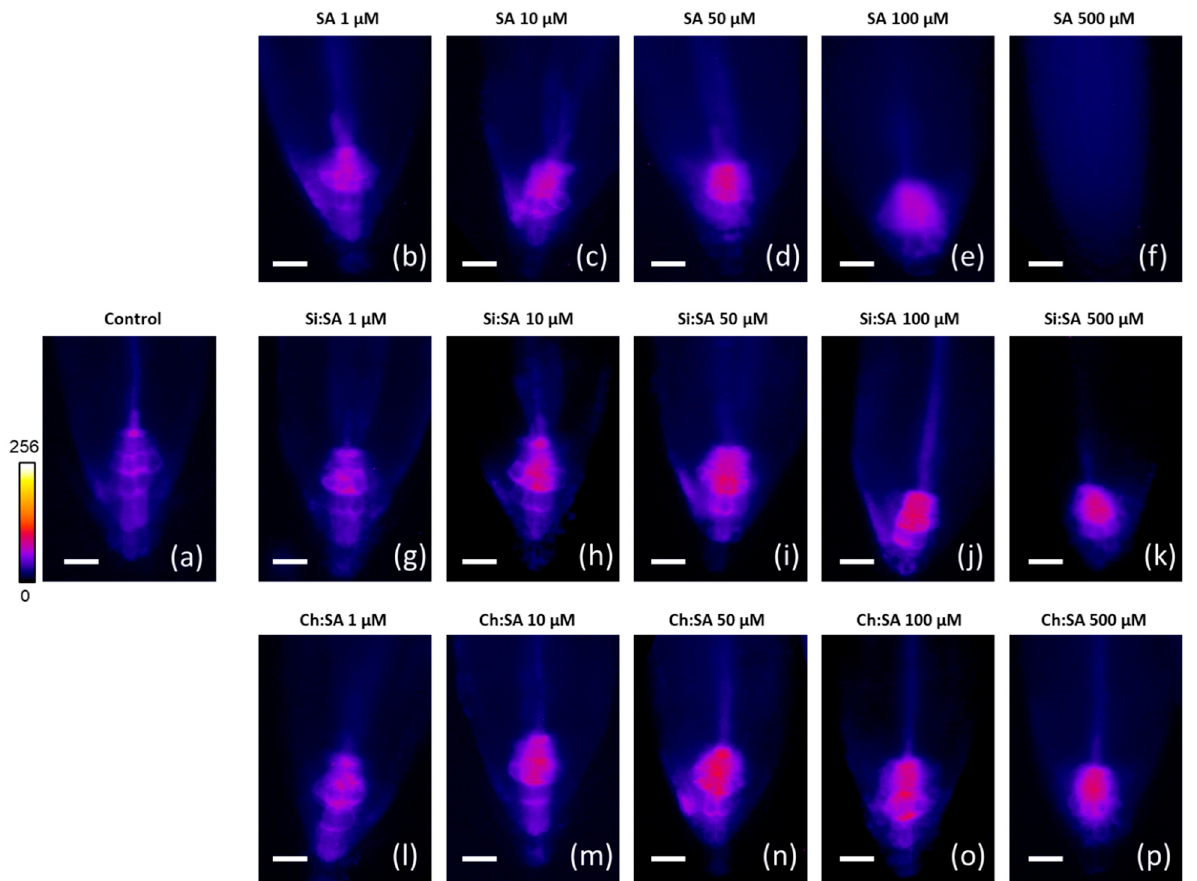
Figure 10. Effect of free SA, Si:SA and Ch:SA on root fluorescence in Arabidopsis thaliana DR5::GFP plants. Five-day-old plants were transferred to media containing the different SA treatments and plant hormones were measured 5 days later. The scale represents 100 µm.